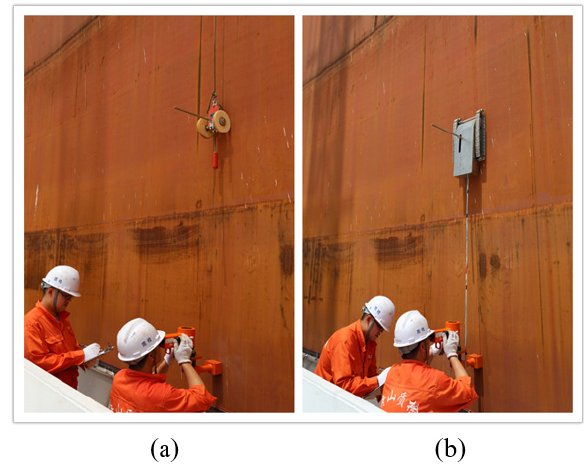
Figure 14. Internal measurement progress with ( a ) trolley and ( b ) TWCR. Table 5. Radial deviation with trolley and tracked wall-climbing robot (TWCR) (internally). Radial Deviation Ring Number